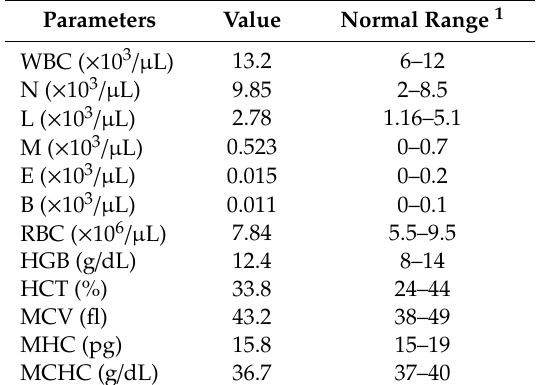
Figure 2. Hypergammaglobulinemia on serum protein electrophoresis from a horse affected by dermal geotrichosis for two months. Table 1. Hematology profile from a horse affected by dermal geotrichosis for two months, with severe dermatitis, exhibiting fever, inappetence, elevated heart and respiratory rate at the time of blood sampling.